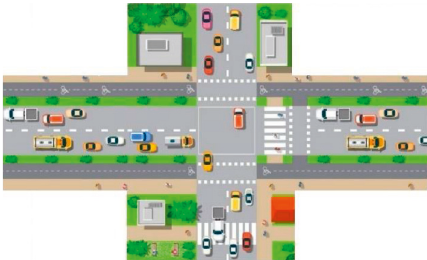
Figure 4: Vehicular ad hoc networking for cross-routes in intel- ligent transportation.